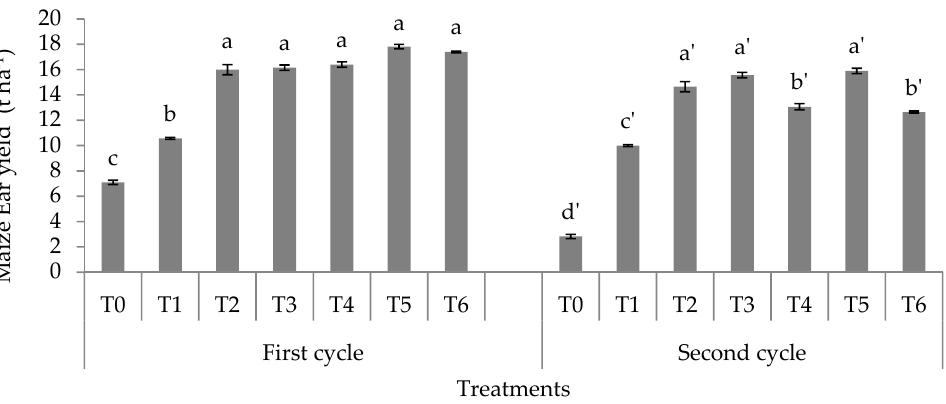
Figure 10. Effects of treatments on dry weight of maize aboveground biomass. Means with the same letter above the bars within a crop cycle are not significantly different at p ≤ 0.05. Bars represent the mean values ± standard error .